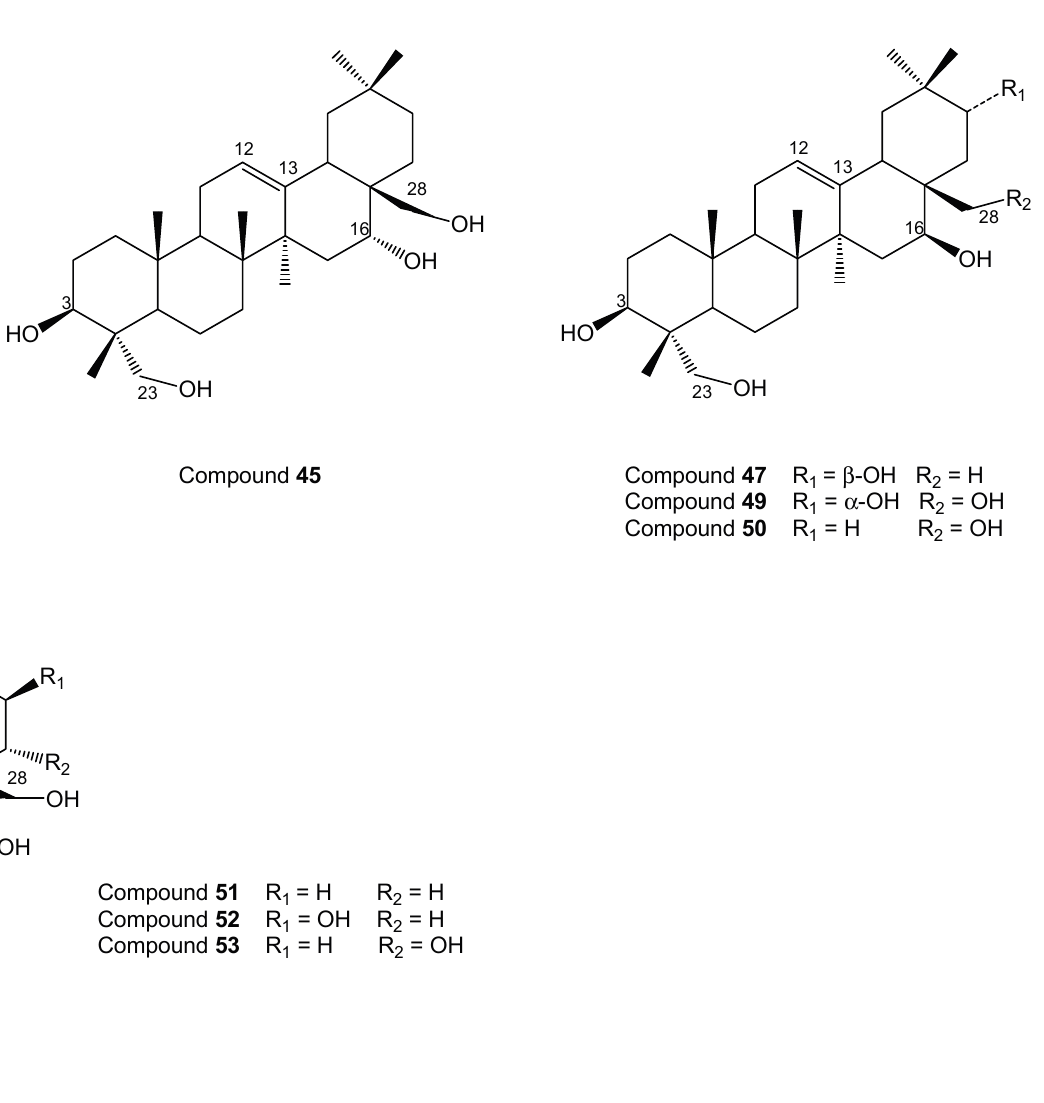
Figure 2. Chemical structures of compounds 37 , 45 , 47 , 49 – 53